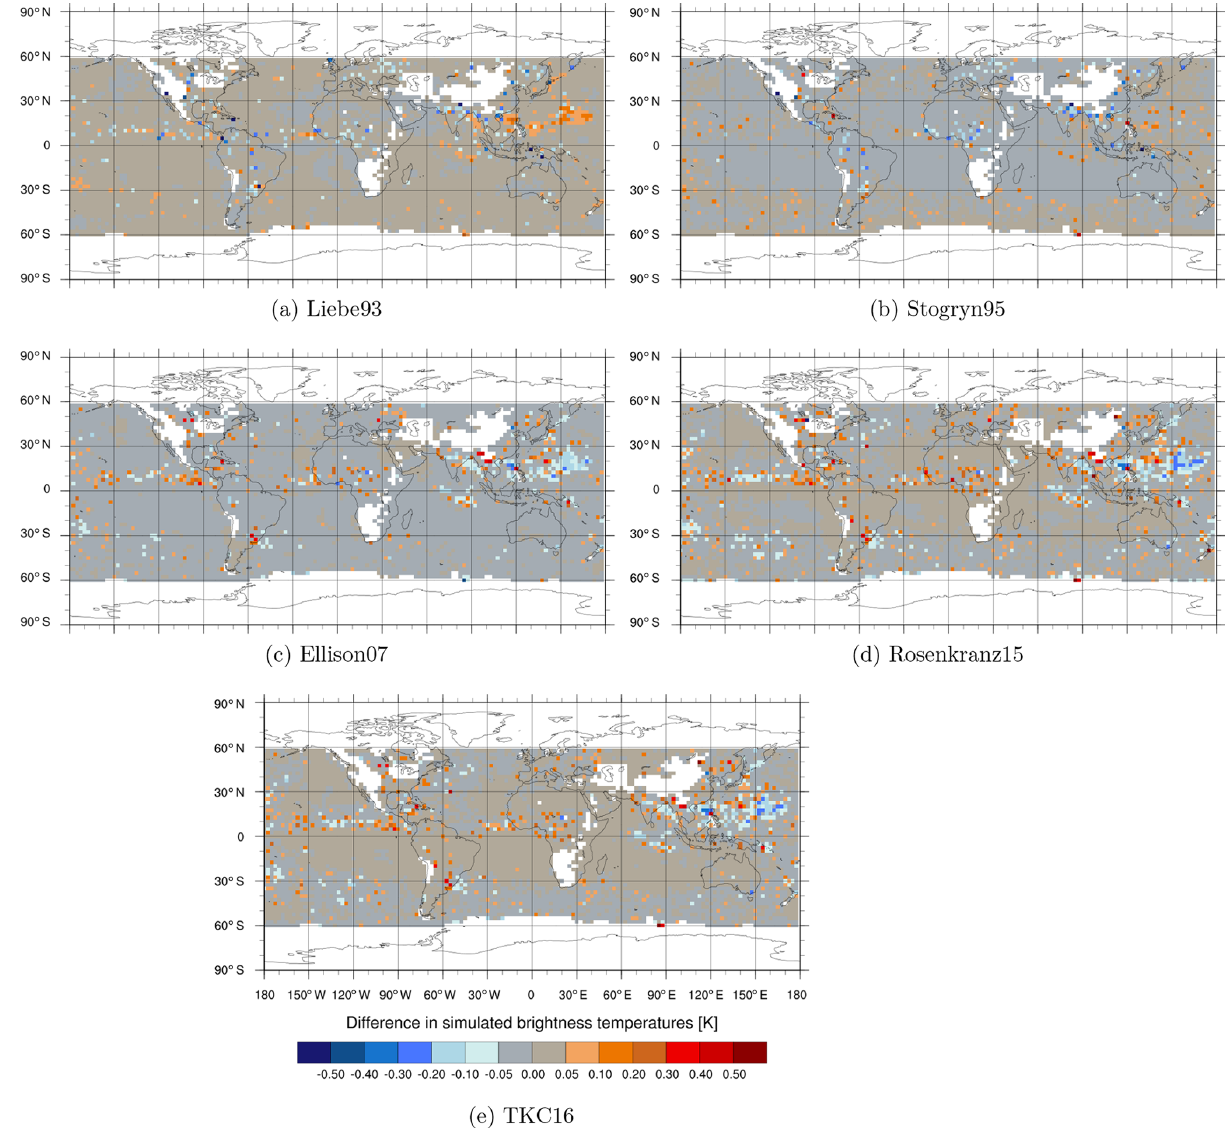
Figure 6. As in Fig. 3 but for channel 183 ±